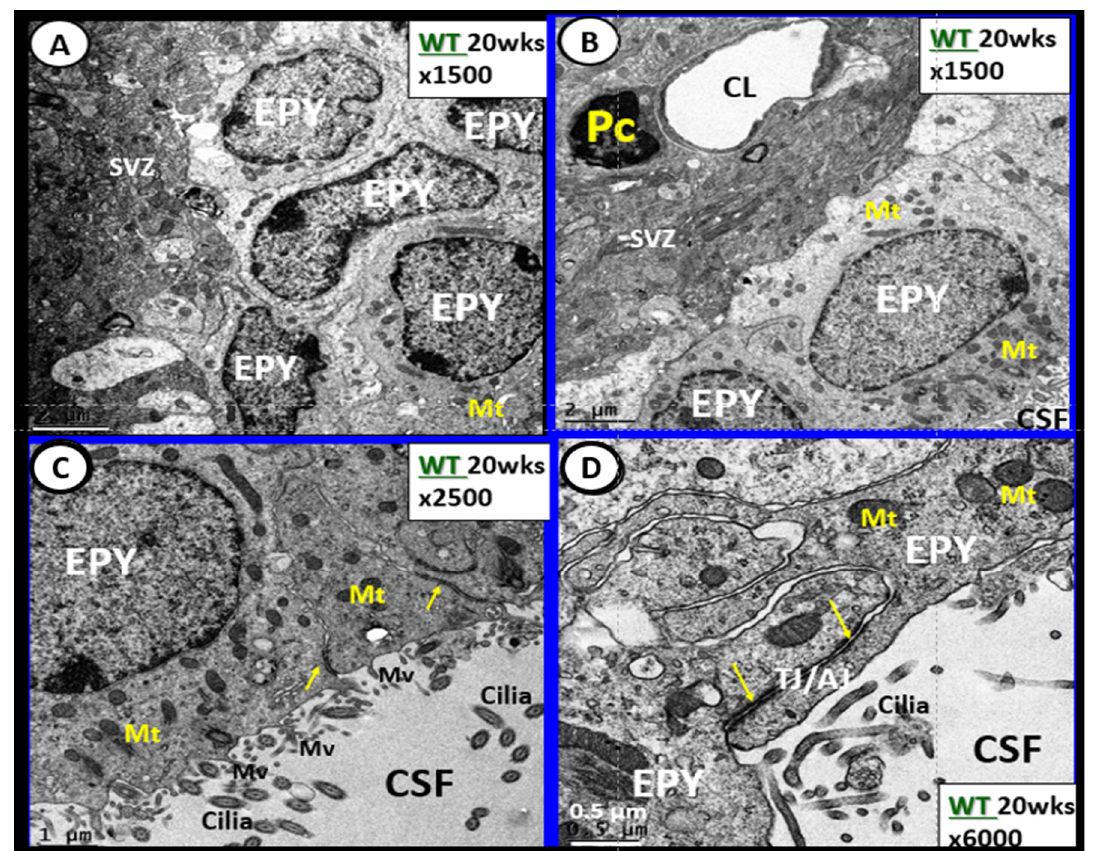
Figure 13 . Ependymal cells lining the ventricular cerebrospinal fluid (CSF) system of the aqueduct in female control 20 week old models. Panel A illustrates that not all ependymal cells (EPY) are cuboidal but may lie flattened and be multilayered at the subventricular zone (SVZ) region of the adjacent neuropil. Panel B demonstrates the more classical cuboidal morphologic phenotype of the EPY cells that line the CSF ventricles. Note the close 5 µm distance between the EPY cells and fenestrated capillary within the SVZ neuropil. The adjacent capillary neurovascular units (NVU) in the SVZ do not have a similar coverage by astrocytes as in the cortical regions but pericytes (Pc) are frequently noted and this capillary appears to be fenestrated due the thinning of the ECs. Panel C depicts the ependymal cilia with the classical 9:2 arrangements of cytoskeletal proteins within them in addition to multiple microvilli (Mv) on the apical surface facing the CSF. Panel D demonstrates the overlapping and interdigitations of EPY cells, and also the staining of the very electron dense tight and adherens junction (TJ/AJ) proteins (arrows) and desmosomes that create the barrier functions of the EPY cells in some regions of the ependymal lining of the CSF. While these EPY cells are located in the aqueduct they also are representative of the EPY cells found throughout each of the four ventricles and lining of choroid plexus (CP) that provides the CP with its barrier function. As noted in these images, the EPY cells form the structural and functional barrier of the choroid plexus. CL = capillary lumen.